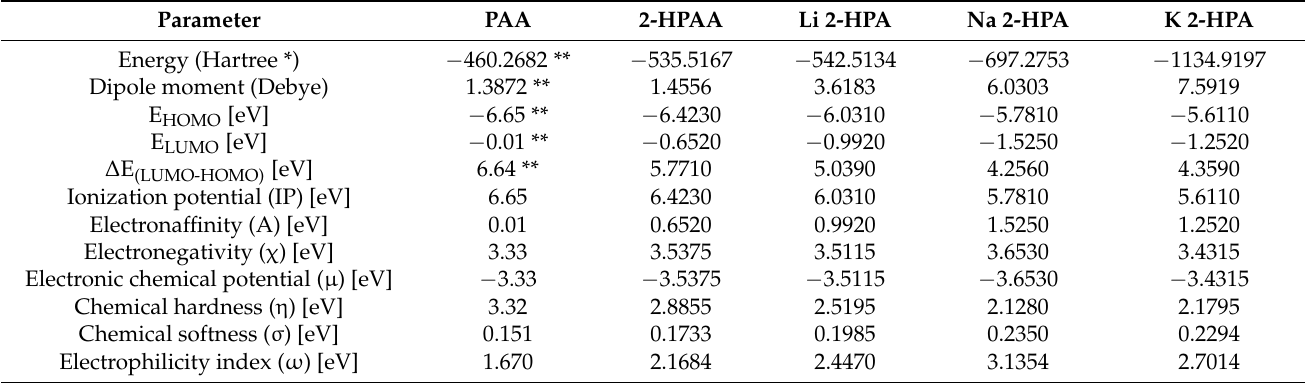
Table 3. Calculated parameters of chemical reactivity of phenylacetic acid (PAA), 2-hydroxyphenylacetic acid (2-HPAA) and its chosen alkali metal